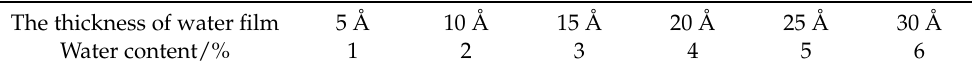
Table 2. The water content of kaolinite according to the thickness of the water